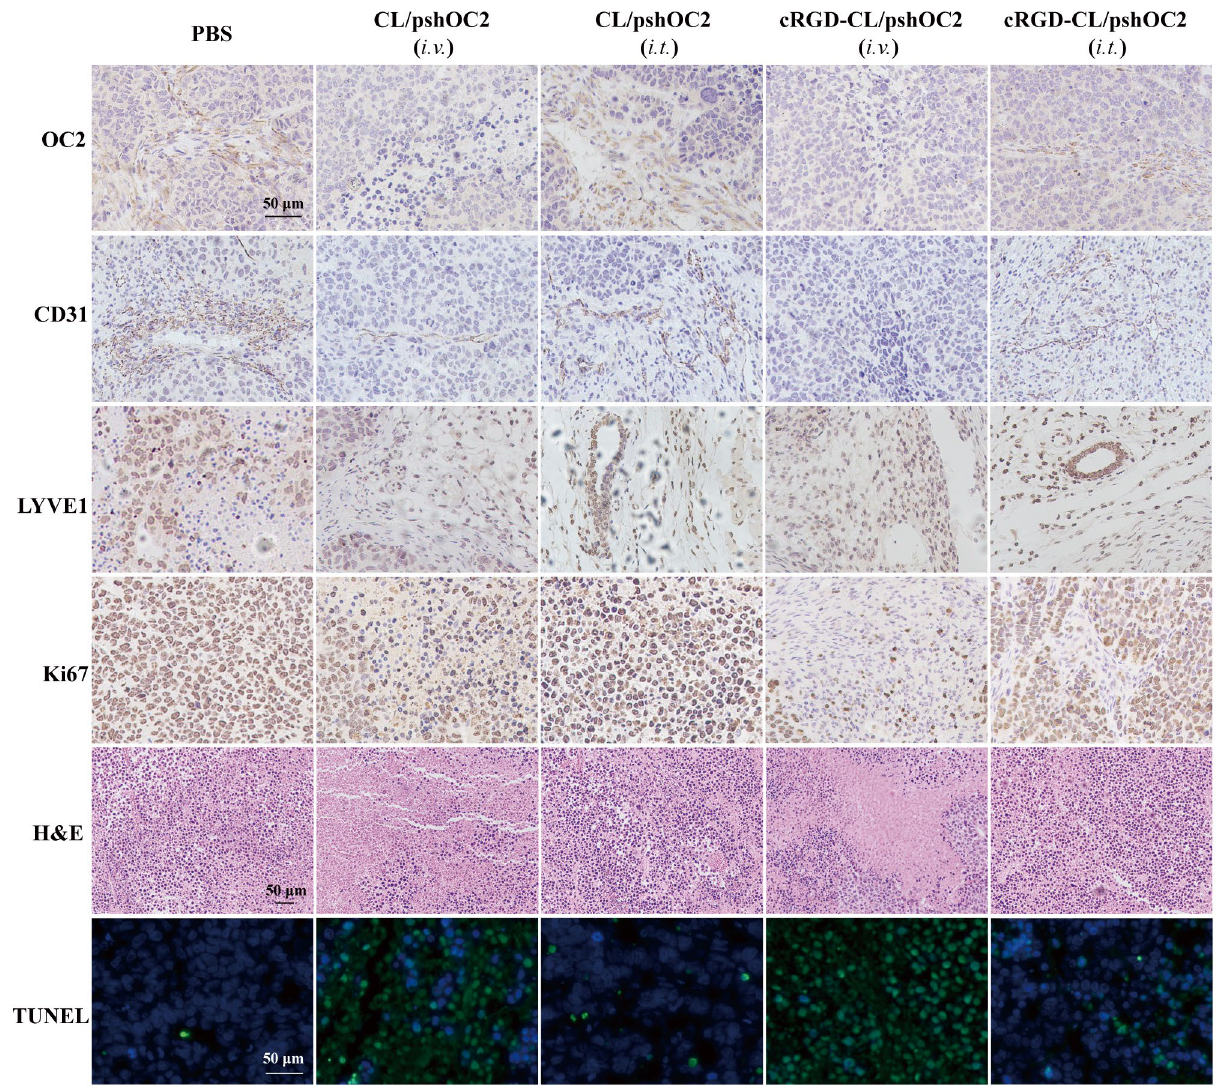
Figure 7. Representative Images of H&E, IHC and TUNEL Assays. Tumor tissues treated with CL/pshOC-2 and cRGD-CL/pshOC-2 were fixed and sectioned. H&E staining and the protein expression of Ki67 for tumor growth, CD31 for tumor angiogenesis, LYVE1 for tumor lymphangiogenesis and TUNEL for tumor cell apoptosis. Scale bar: 50 μm.